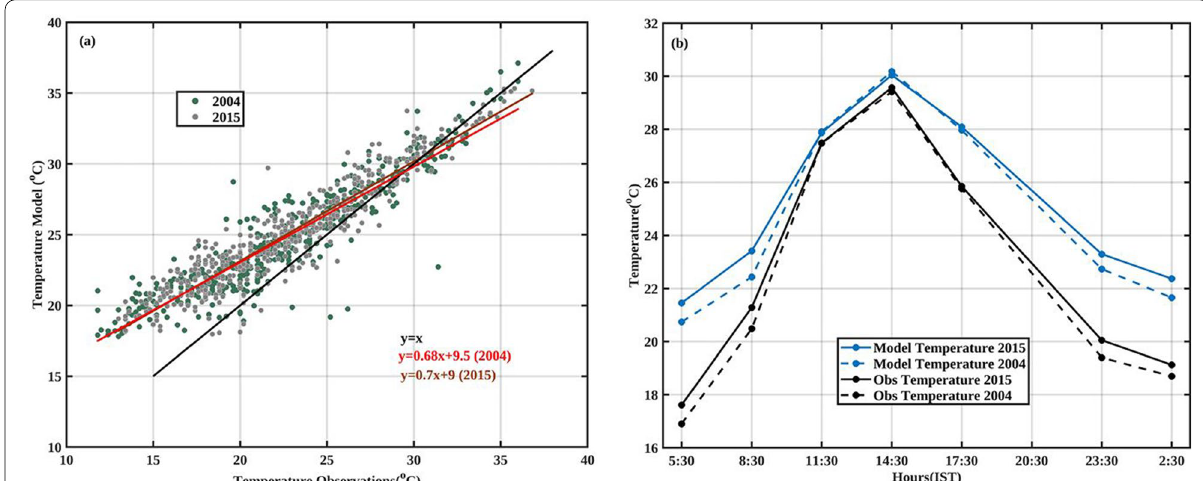
Fig. 2 Comparing the model simulated temperature values with observations. a Scatter plot showing the relationship between model-simulated temperature and the observations for 2004 and 2015. b Diurnal temperature variation over the city from model and observations for 2004 and 2015